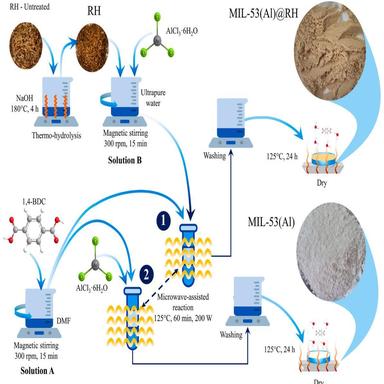
Schematic of the synthesis of 1) MIL-53(Al)@RH and 2) pristine MIL-53(Al).